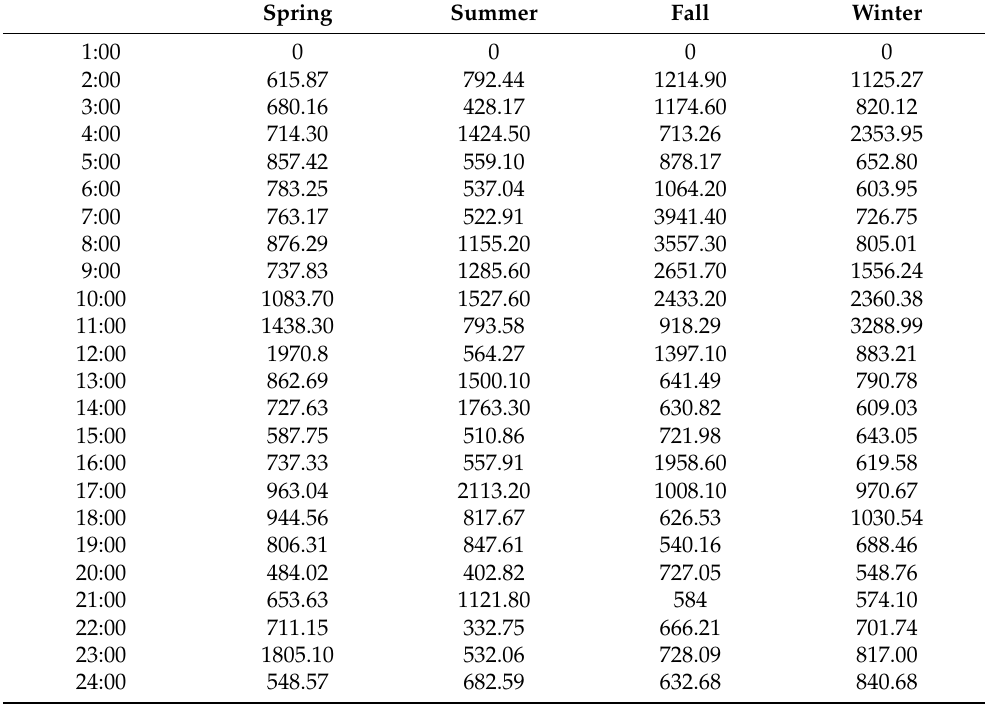
Table 2. Seasonal hourly ramp rate standard values.